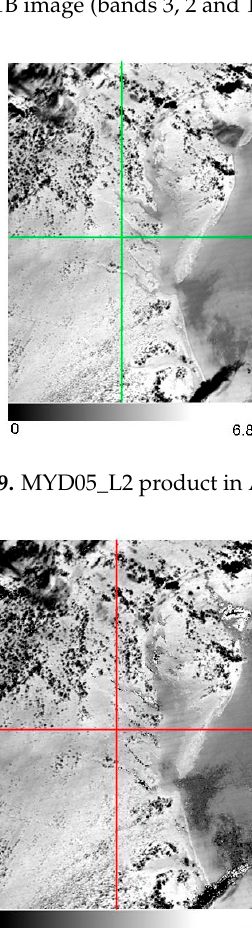
Figure 10. Water vapor content retrieved by NN.